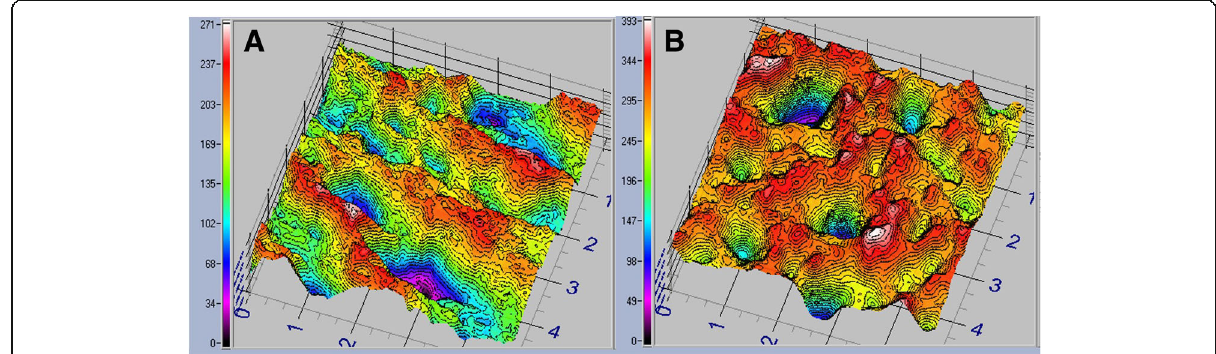
Fig. 11 Surface scans of a 5 × 5 mm area on crest slopes. The stoss slopes ( a ) show elongated scratches corresponding to the main northeast- southwest flow direction, which superimposes to the secondary flow forming the crests and troughs. Pits of various sizes on lee slopes ( b ) are formed by the action of the secondary flow forming crests and troughs